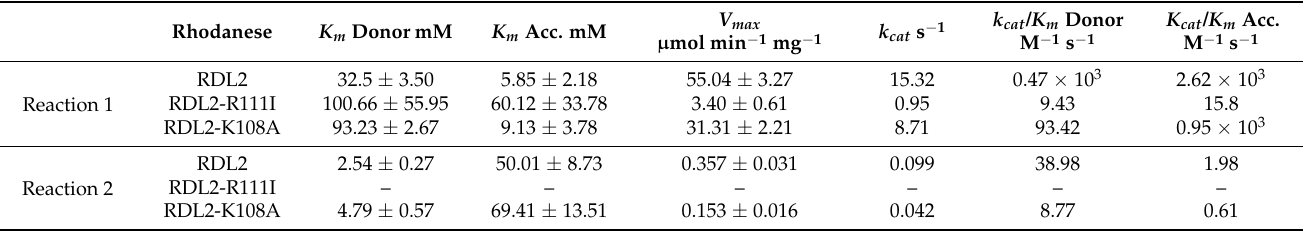
Table 2. Kinetic parameters of RDL2-catalyzed Reactions 1 and